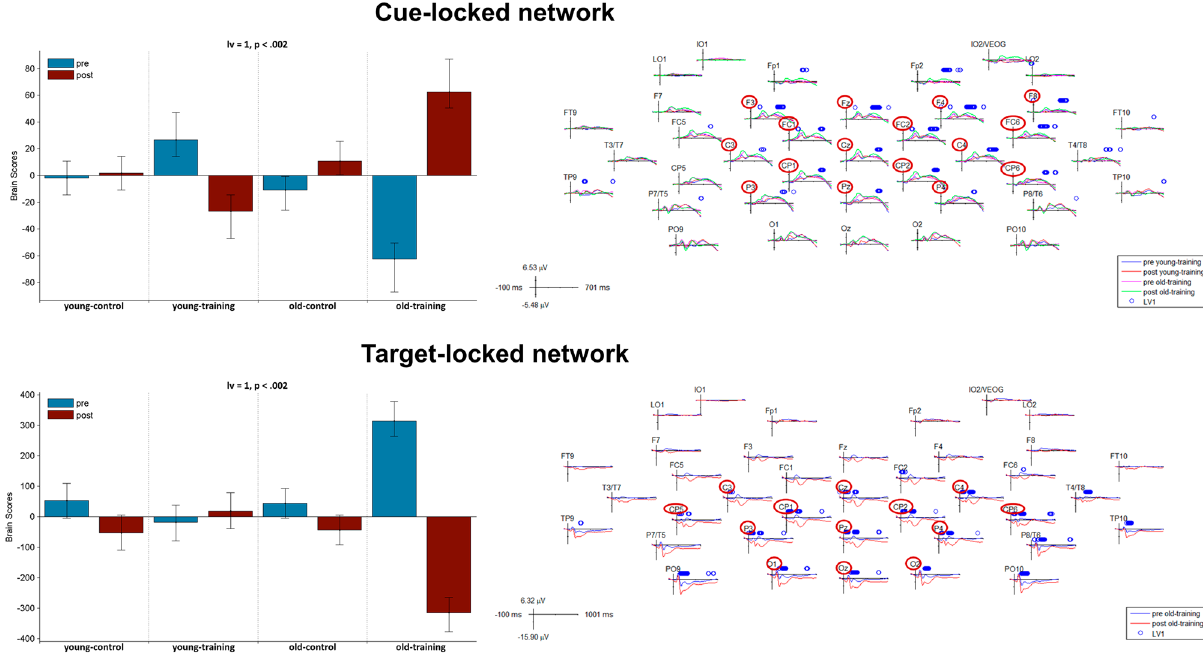
Figure 6. PLS analysis results on cue-locked (top row) and target-locked (bottom row) ERP for the group by condition effect (pre- vs. post-training task). On the left side, the bar graph depicts the contrast between experimental groups across age and training conditions that was significantly expressed across electrodes and timepoints as determined by permutation tests, with error bars denoting 95% confidence intervals. On the right side, the ERPs for all of the electrodes used in the original study are shown and the blue circles represent those timepoints where the detected contrast (LV) reaches high significance as determined by bootstrapping. The cue-locked waveforms show the trained task’s ERPs for the young-training group’s pre-training (blue) and post-training (red) as well as the old-training group’s pre-training (magenta) and post-training (green) conditions and the blue circles represent those timepoints where the bootstrap ratio is larger than 4.5. The target-locked waveforms show the trained task’s ERPs for the old-training group’s pre-training (blue) and post- training (red) conditions, and the blue circles represent those timepoints where the bootstrap ratio is larger than 8.1. Electrodes highlighte with red circles constitute the training-relevant electodes that were used for further analyses with resting-state MSE and